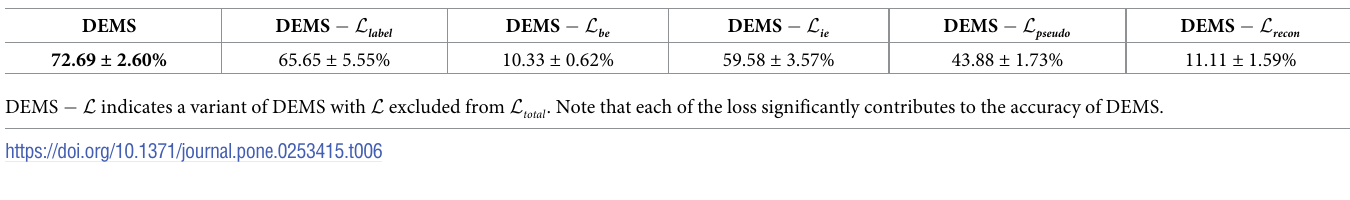
The remains except for the target dataset are used for sources. The best method is in bold, and the second best one is underlined. Note that DEMS gives the best performance.